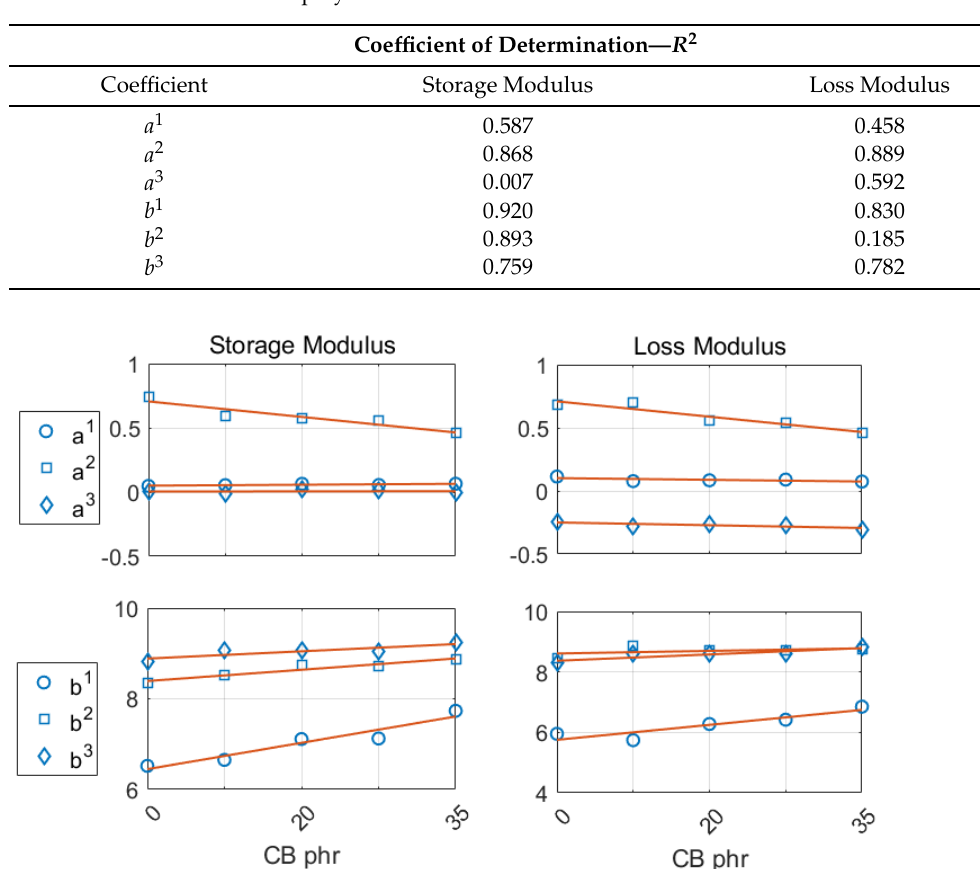
Table 7. Correlation between polynomial coefficients and CB concentration.